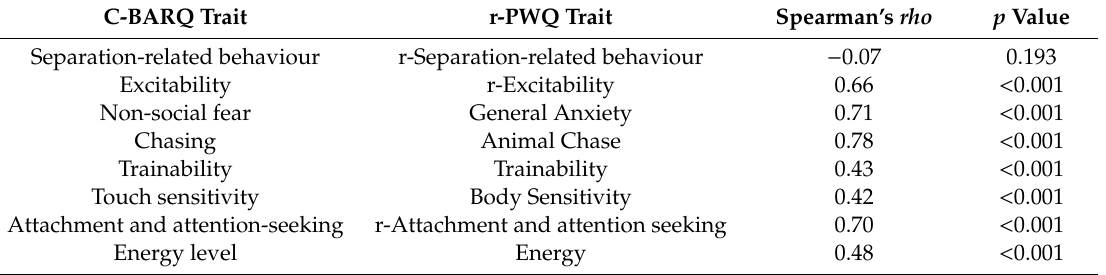
Table 5. Correlation coe ffi cient (Spearman’s rank) between Z-scores for C-BARQ and r-PWQ traits.